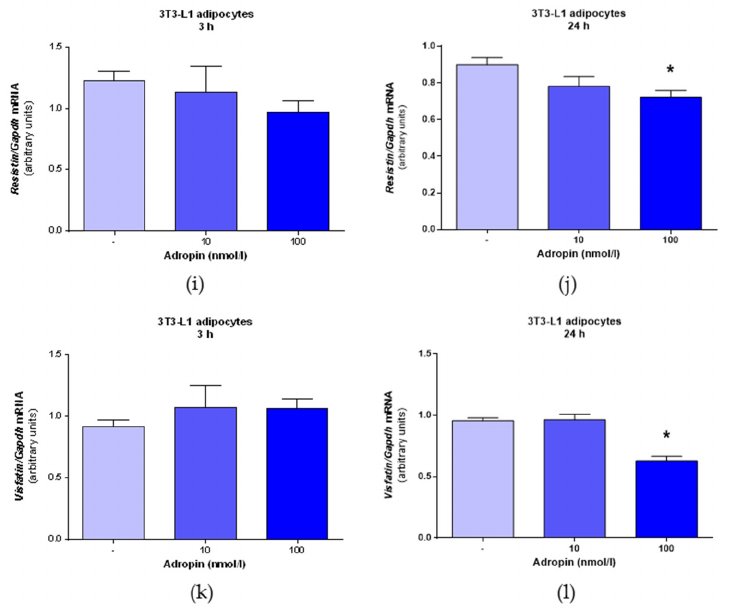
Figure 5. Effects of adropin on mRNA expression of adiponectin, resistin and visfatin in rat adipocytes and 3T3-L1 cells. Expression of adiponectin mRNA in rat adipocytes treated with adropin or vehicle (sterile distilled water) (-) for 3 ( a ) or 24 h ( b ). Expression of resistin mRNA in rat adipocytes treated with adropin for 3 ( c ) or 24 h ( d ). The mRNA levels of visfatin assessed in rat adipocytes incubated in the presence of adropin for 3 ( e ) or 24 h ( f ). Expression of adiponectin mRNA in 3T3- L1 cells treated with adropin for 3 ( g ) or 24 h ( h ). Resistin mRNA expression in 3T3-L1 cells treated with adropin for 3 ( i ) or 24 h ( j ). Visfatin mRNA levels in 3T3-L1 cells determined in cells exposed to adropin for 3 ( k ) or 24 h ( l ). Results are the mean ± SEM ( n = 6). p < 0.05 (*).